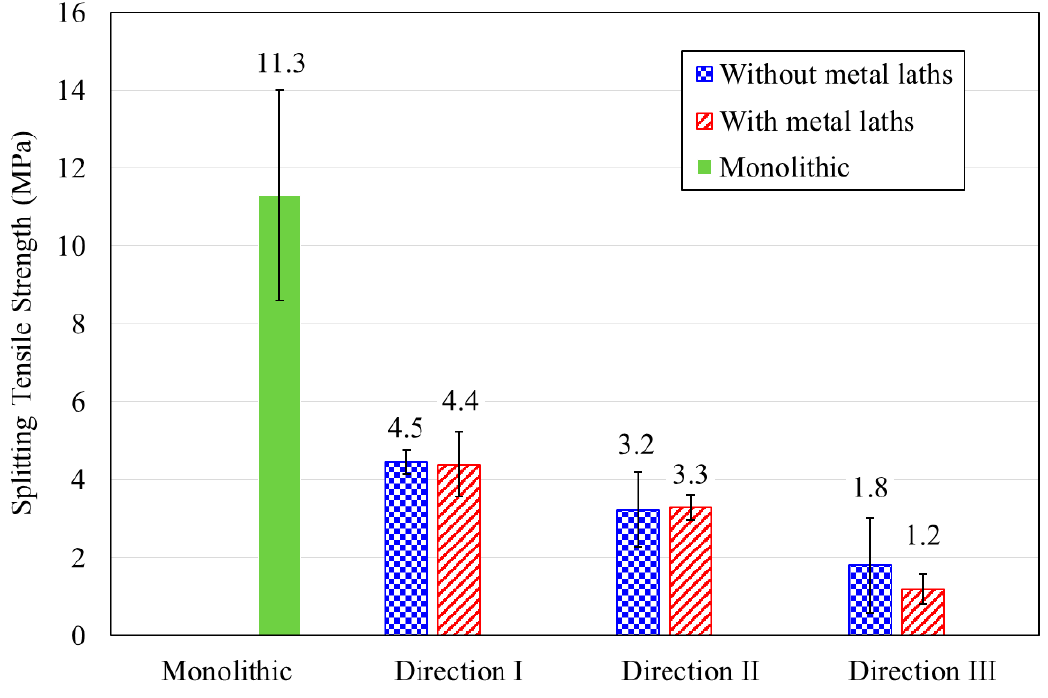
Figure 10. Splitting tensile test results.